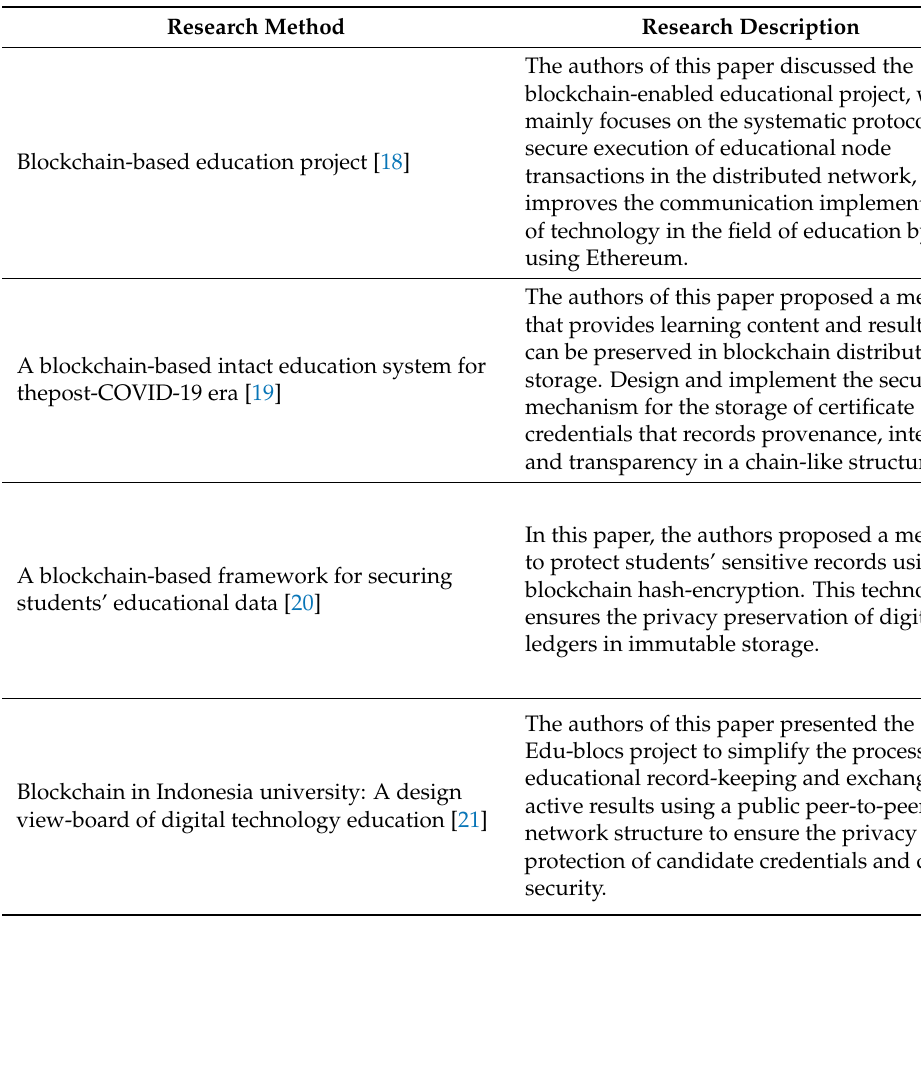
Table 1. Related